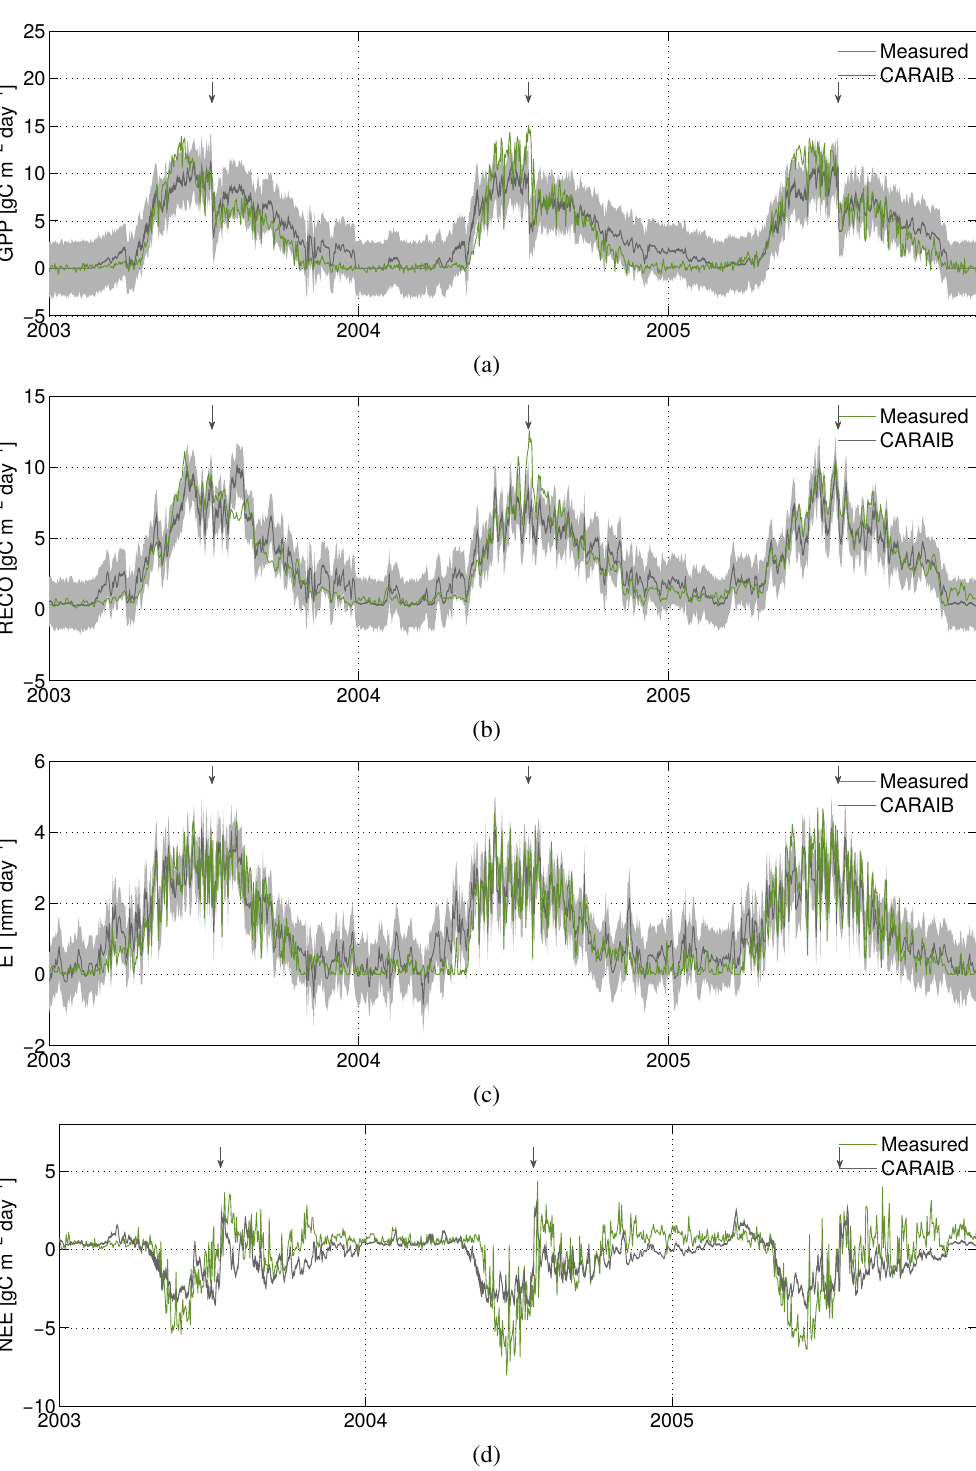
Figure 3. Measured and modelled GPP (gCm − 2 day − 1 ) (a) , RECO (gCm − 2 day − 1 ) (b) , ET (mmday − 1 ) (c) and NEE (gCm − 2 day − 1 ) (d) at the Monte Bondone site for the inferred homoscedastic error model (inversion HO2). The ranges of the prediction uncertainty due to parameter uncertainty and the 95% total predictive uncertainty (only for GPP, RECO and ET) are depicted by the dark and light grey shaded areas, respectively. Vertical arrows indicate the dates of the grass